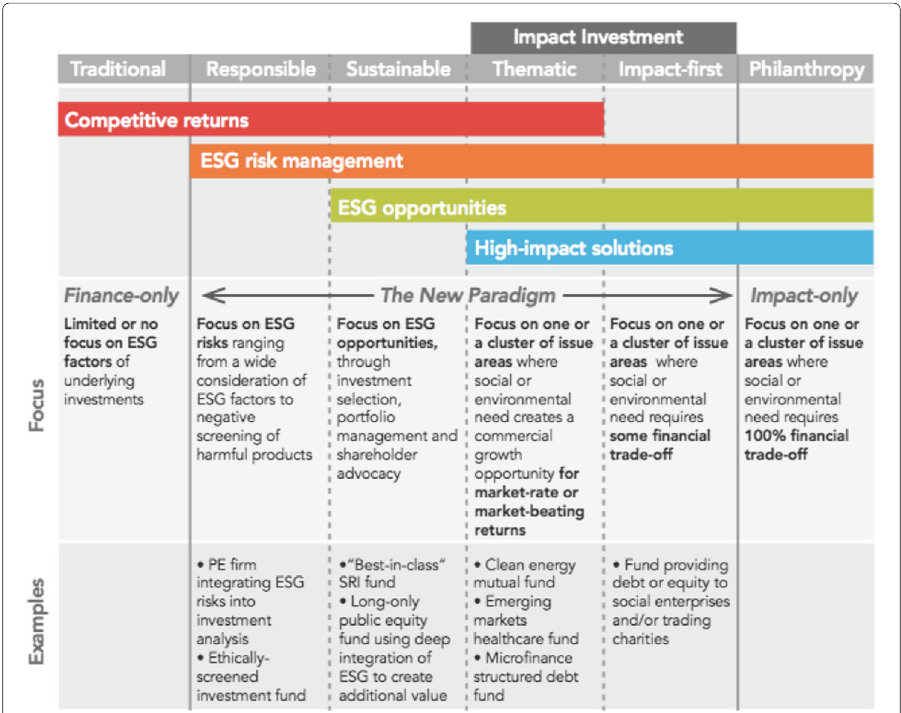
Fig. 1 The impact investment spectrum. The investment spectrum ranging from traditional finance-only investments on the left hand side to impact-only philanthropy on the right hand side. Impact investing represents the new ‘middle-ground paradigm’ comprising of different sub-divisions (impact-first, thematic, sustainable and responsible